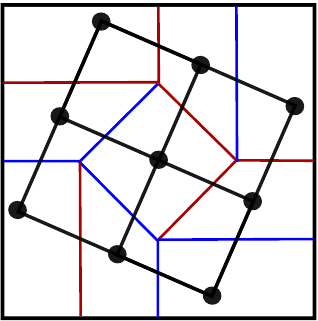
Figure 5. The crease pattern for the square twist shown in Fig. 4 is Fig. 5. The crease pattern for the square twist shown in Figure 3 is shown with its corresponding graph overlaid in black. In the crease shown with its corresponding graph overlaid in black. In the crease pattern the red corresponds to mountain folds and blue to valley pattern the red corresponds to mountain folds and blue to valley folds. folds. vertices (links) on the boundaries separating four segments (joints) is representative of a four-bar